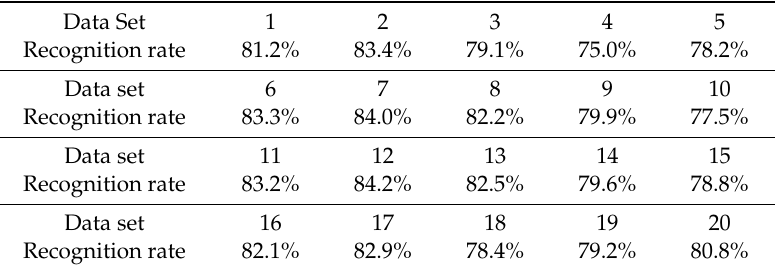
Table 4. The recognition rate of the test